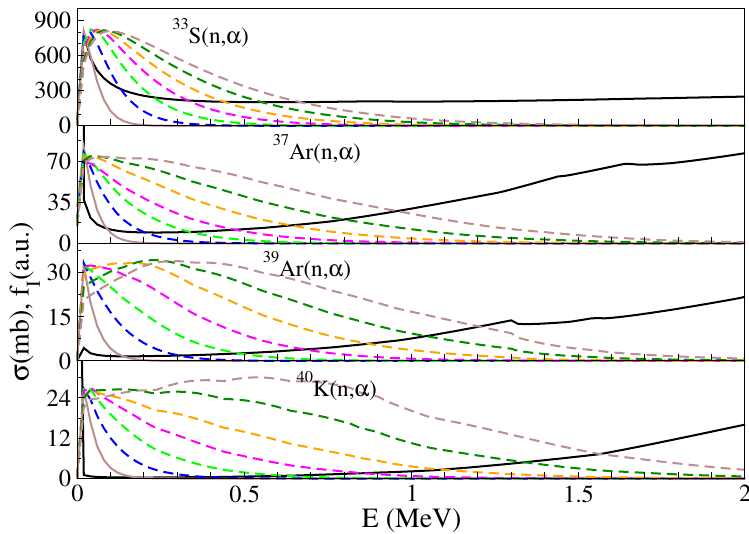
Figure 8. The same as Figure 7, but for 33 S, 37 Ar, 39 Ar, and 40 K target